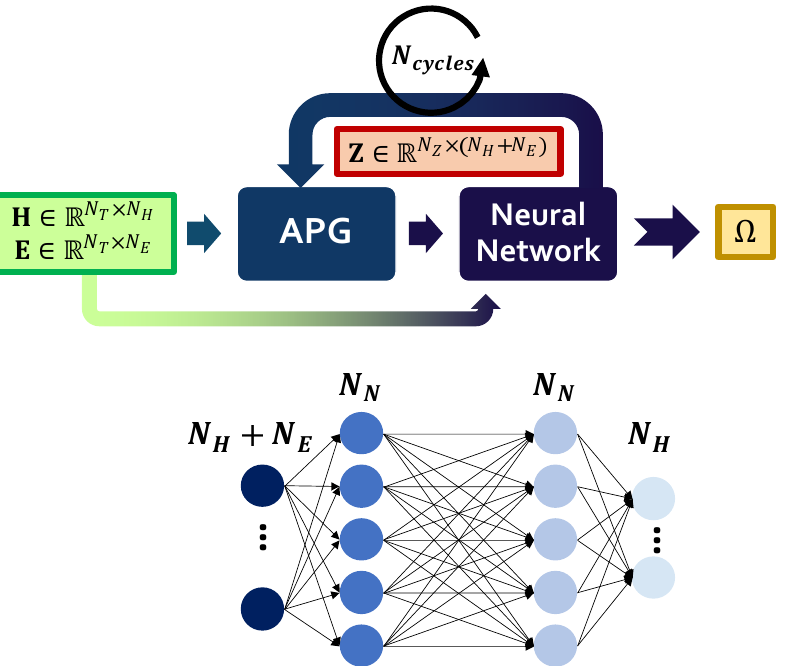
Figure 4. General scheme of OCCNN with its main procedural